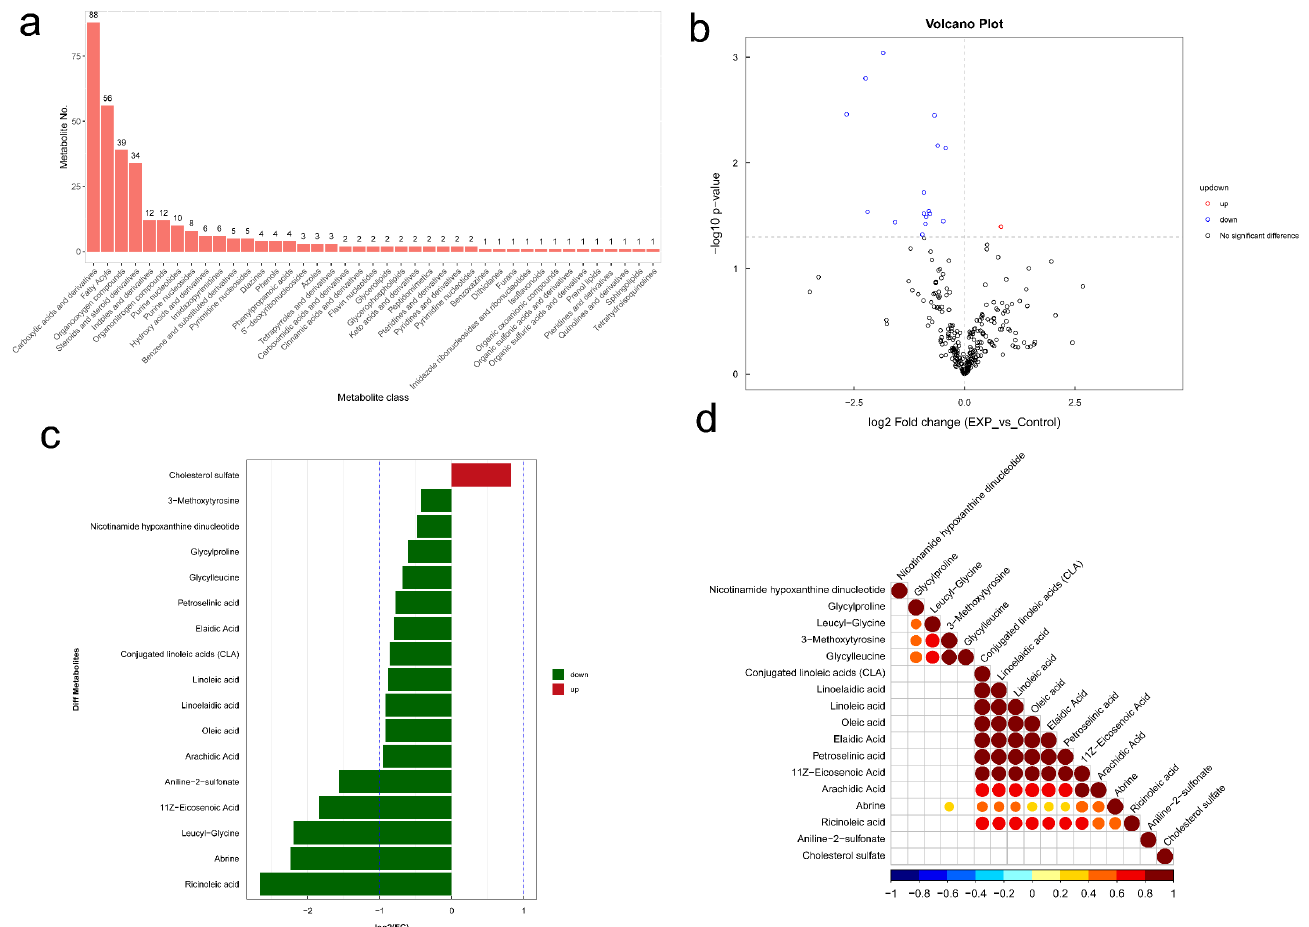
Figure 6. Changes of gut-microbiome-associated metabolites in BLCA patients (BLCA patients, EXP group; healthy individuals, CON group). ( a ) Quantitative statistics of the identified metabolites in each chemical classification. Each bar in the figure stands for a different chemical classification attribution entry. ( b ) Volcano plot was used to visualize the differential analysis for all metabolites detected. The horizontal coordinate was the log2 value of the fold change (FC), and the vertical coordinate was the log10 value of the significant p -value. Significantly dysregulated metabolites: metabolites meeting FC > 1, p -value < 0.05, are shown in red; metabolites meeting FC < 1, p -value < 0.05 are shown in blue. Non-significantly dysregulated metabolites are shown in black. ( c ) The fold change of identified metabolites with statistical significances are shown. Upregulation of differential metabolites are shown in red. Downregulation of differential metabolites are shown in green. ( d ) Heatmap of correlation analysis for these significantly dysregulated metabolites. Red indicates positive correlation, blue indicates negative correlation, and white indicates non-significant correlation. The size of the dot is related to the significance of the correlation.